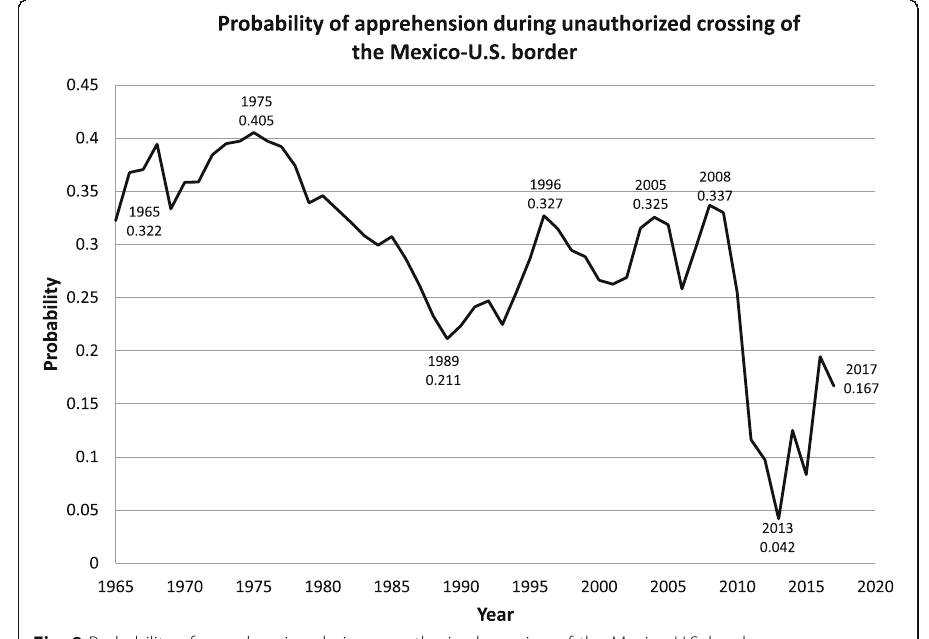
Fig. 9 Probability of apprehension during unauthorized crossing of the Mexico-U.S.